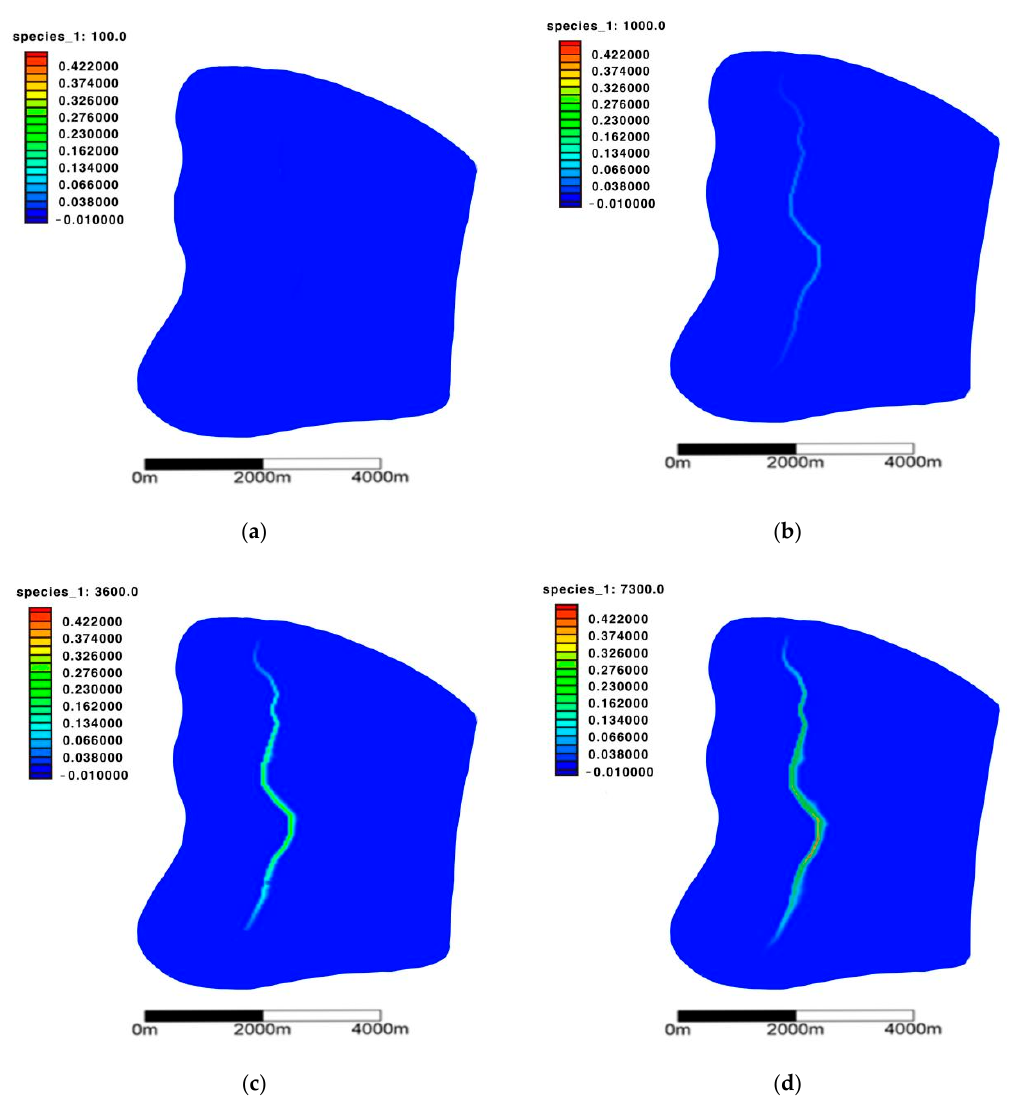
Figure 12. Simulation results of plane migration of the ammonia pollution plume. ( a ) Simulation results of plane migration of the ammonia pollution plume for 100 days ( b ) Simulation results of plane migration of the ammonia pollution plume for 1000 days ( c ) Simulation results of plane migration of the ammonia pollution plume for 3600 days ( d ) Simulation results of plane migration of the ammonia pollution plume for 7300 days.